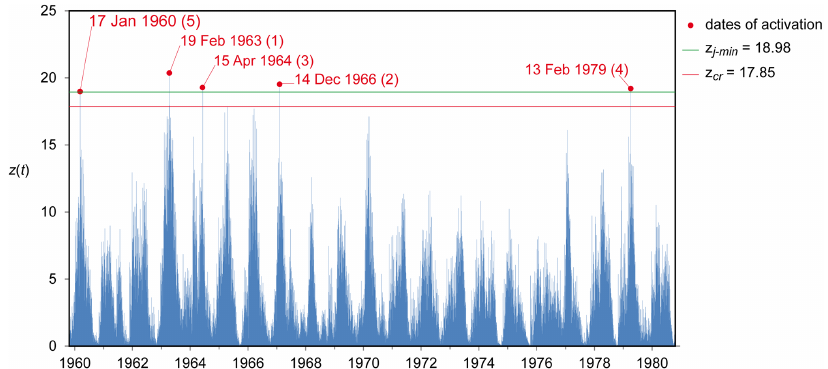
Figure 15. Uncino landslide case study. Mobility function, z(t) , of the average kernel. The red line ( z cr = 17.85) shows the maximum value of the mobility function (critical condition) that is unrelated to known activations. The green line ( z j − min = 18.98) shows the minimum value of the mobility function related to known activations. When the mobility function exceeds the threshold marked by the red line, landslide activation may occur. The red dots represent the maxima of the mobility function corresponding to dates of landslide activation considered for calibration.